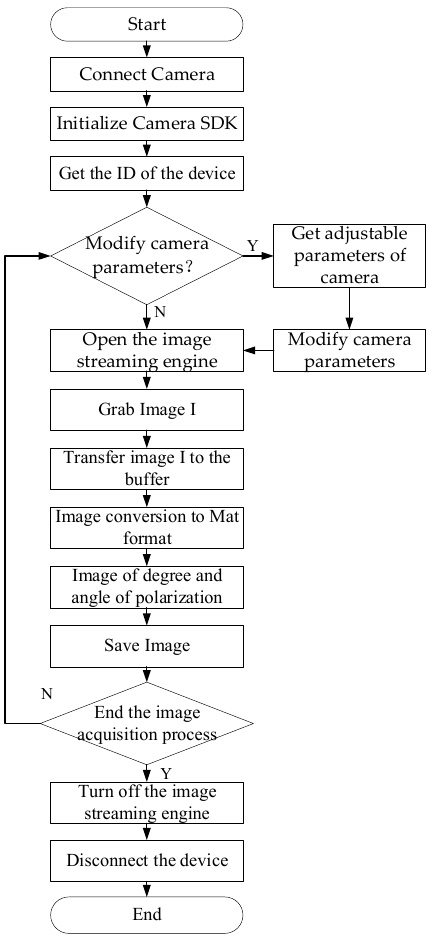
Figure 4. Flow chart of polarization imaging software